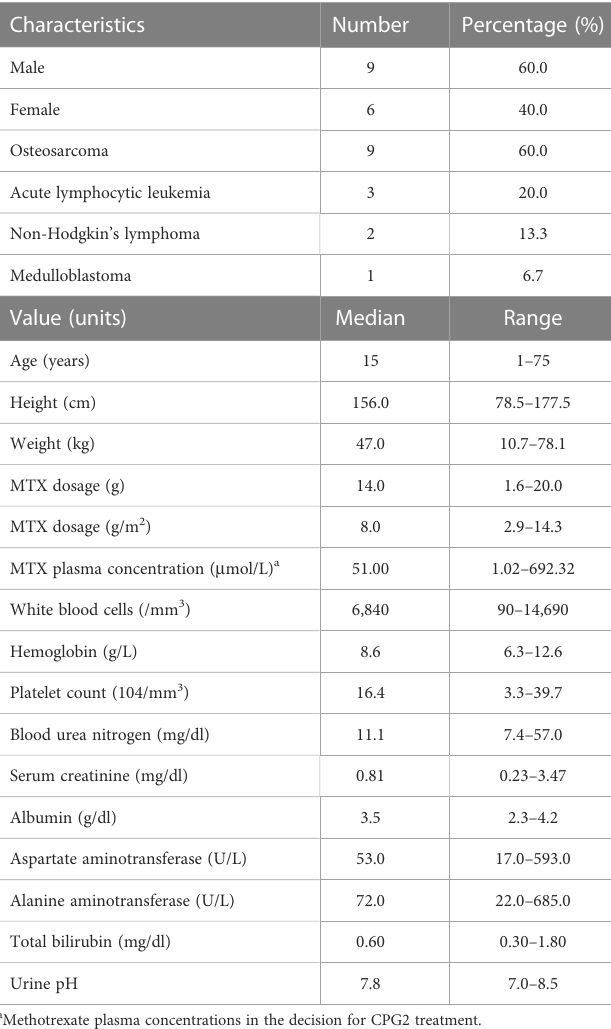
TABLE 2 Demographic data in phase 2 ( n =